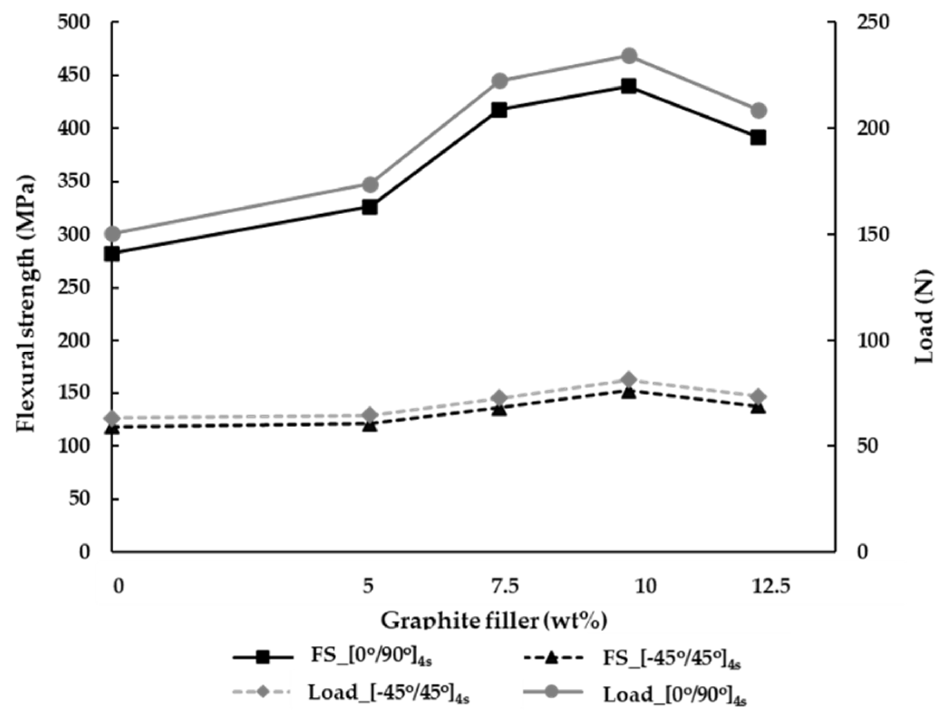
Figure 8. The flexural strength (FS) and maximum load of specimens using the hand lay-up process. The relationship between the flexural strength and percentage of graphite is